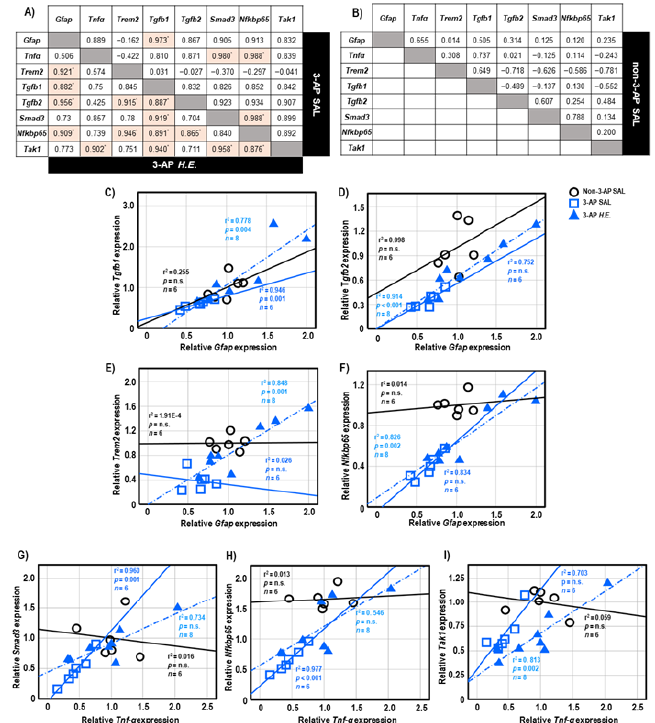
Figure 5. The tables show the gene correlations in the 3-AP group (upper-right), H.E. +3-AP group (Lower-left), and control group in ( A , B ). Scatter plots of significant correlations among groups by Spearman correlational analysis. Gene expression of Gfap was significantly correlated with the gene expression of ( C ) Tgfb1 , ( D ) Tgfb2 , ( E ) Trem2 , and ( F ) Nfkbp65 . Gene expression of Tnf - α was correlated with the gene expression of ( G ) Smad3 , ( H ) Nfkbp65 , and ( I ) Tak1 . The p values were adjusted by Bonferroni correction for multiple comparisons. Indicators: * correlation was significant at p < 0.00625 for gene expression data. Indicators: Non-3-AP SAL group, 3-AP SAL group, 3-AP H.E. group. (cid:35)